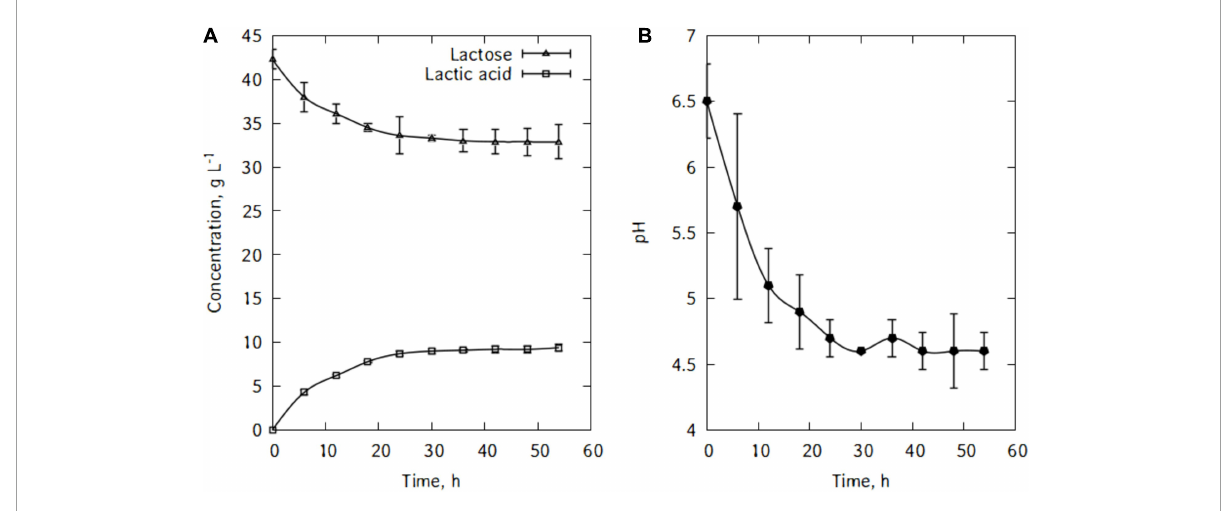
FIGURE5 Evolution of lactose and lactic acid concentrations (A) , and pH during cultivation of L. casei in traditional cheese whey (B) .